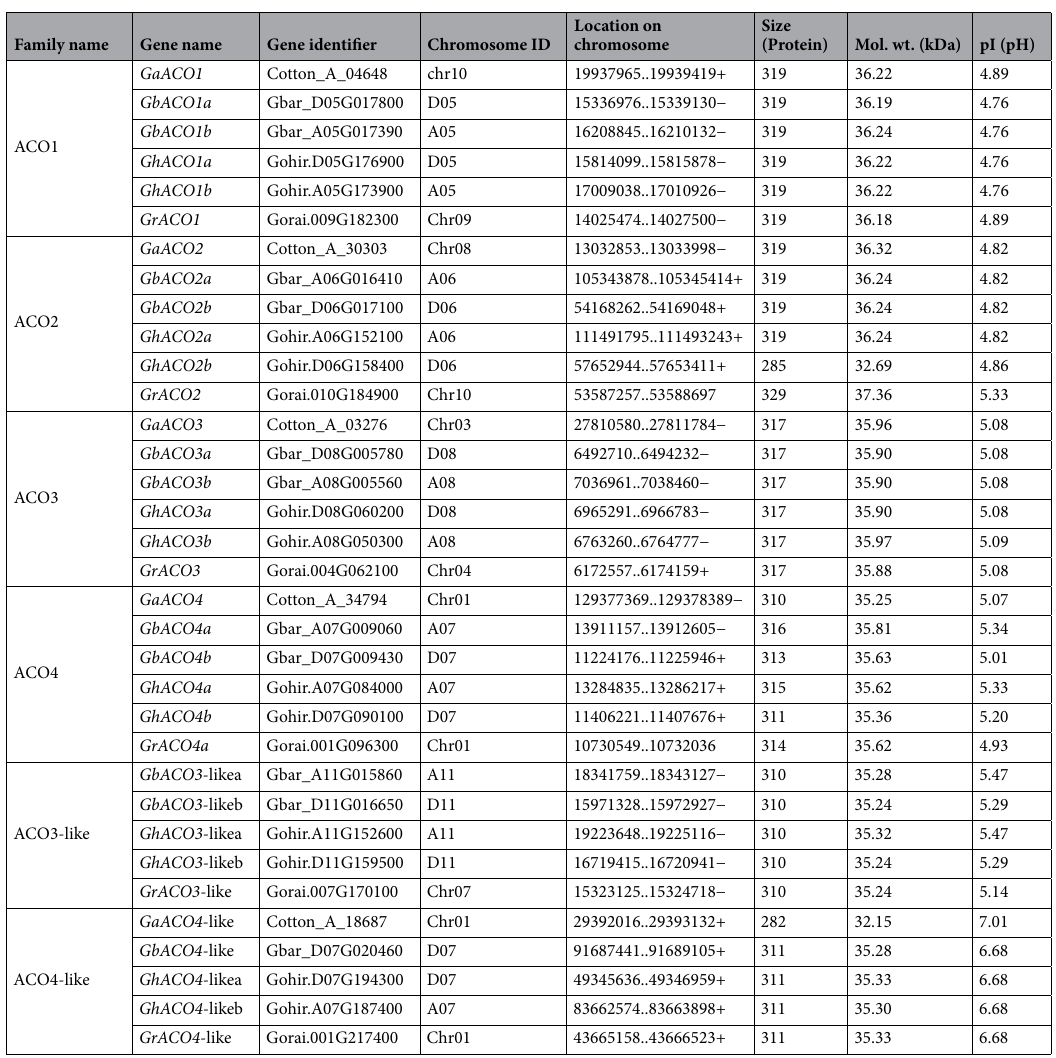
Table 1. Characteristics of ACO isoforms in Gossypium